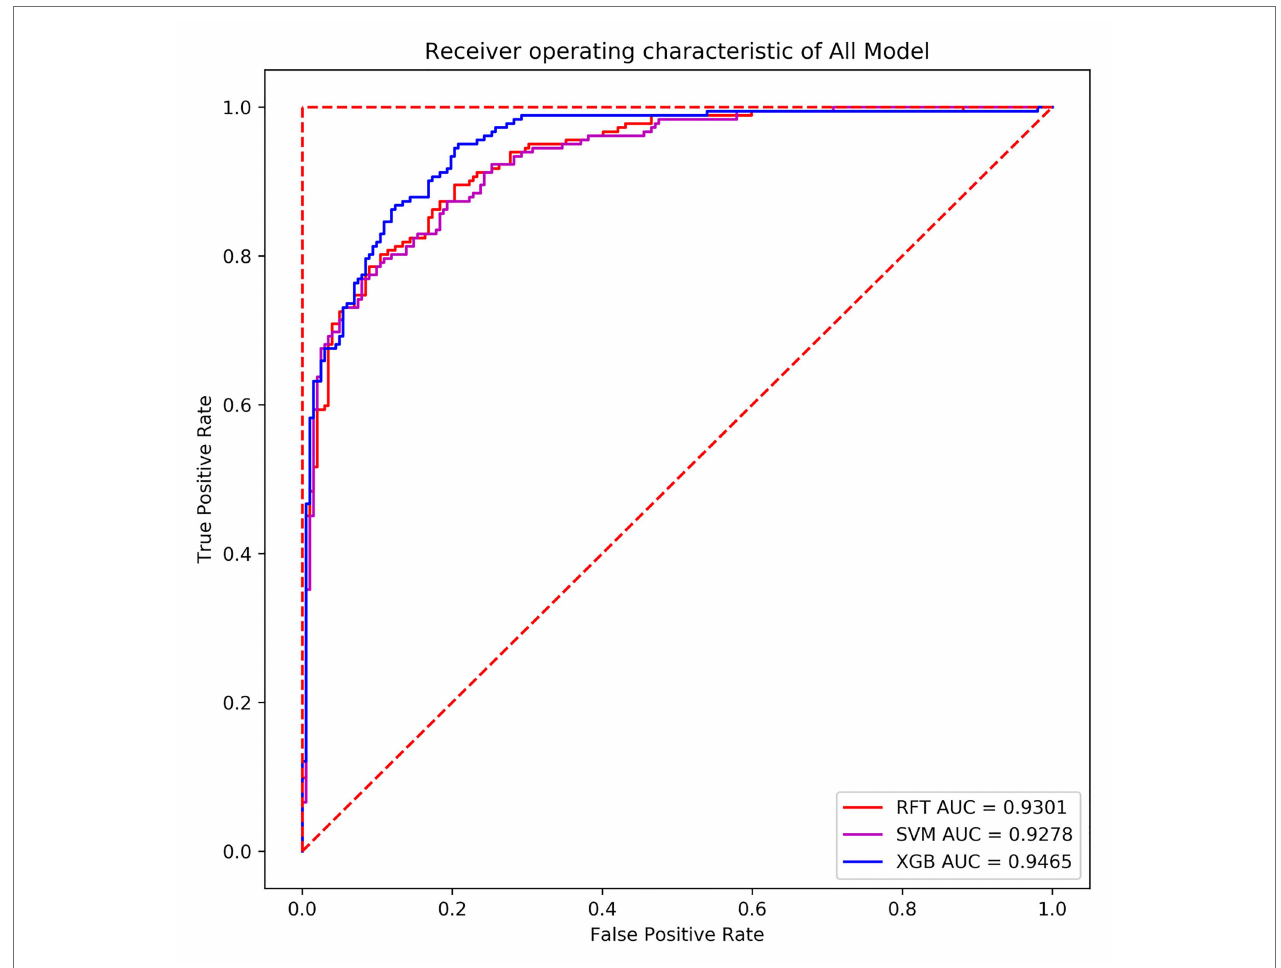
FIGURE 12 | Receiver operating characteristic (ROC) curves of the three